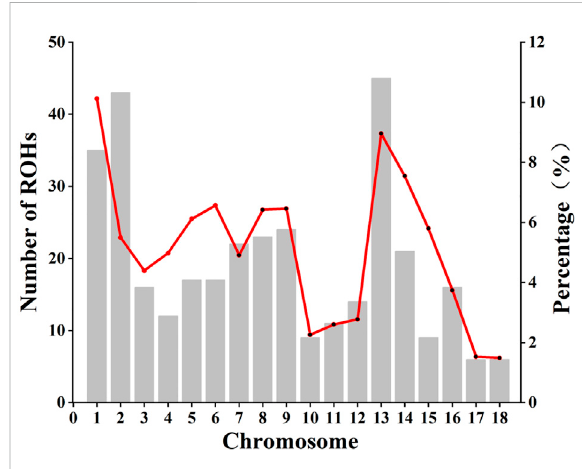
FIGURE 3 The number of runs of homozygosity (ROH) on each chromosome and the proportion covered by ROH. Bars and the red line represent the number of ROH and the ROH coverage, respectively, on each chromosome.